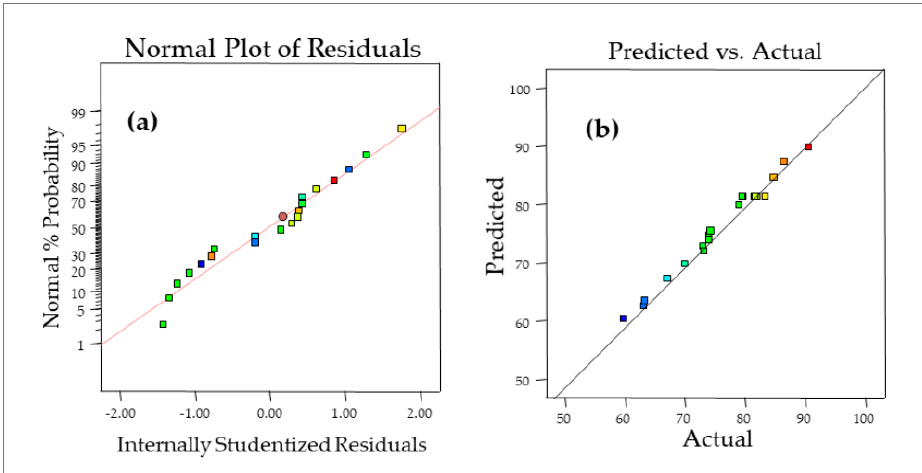
Figure 8. Normality plot of ( a ) residual, ( b ) predicted vs. residual.